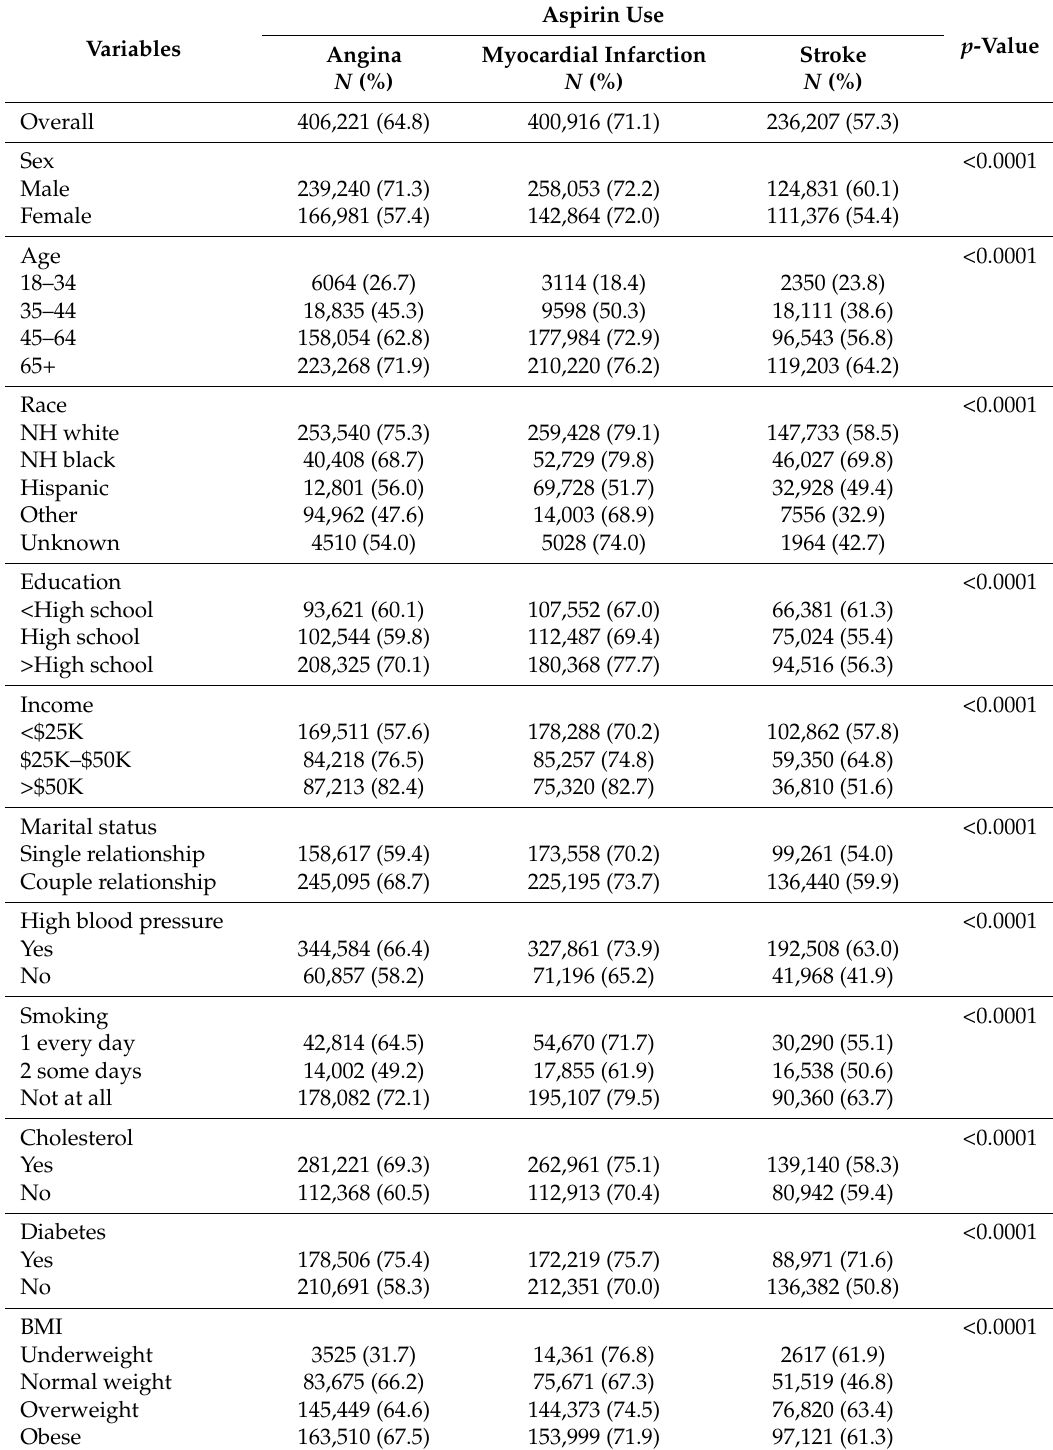
Table 3. Weighted percentages of respondents with cardiovascular disease that take aspirin daily or every other day: BRFSS